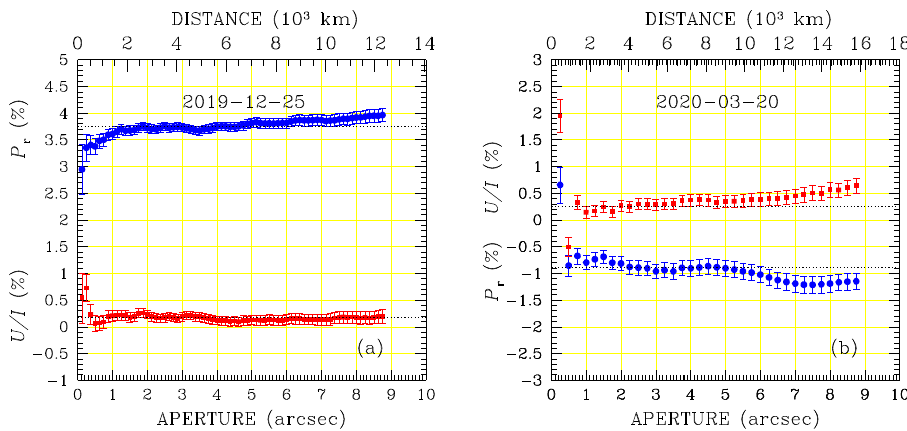
Fig. 5 Aperture polarimetry of 2I/Borisov in the R F fi lter. Blue fi lled circles refer to P r and red fi lled squares refer to U / I . The dotted black solid lines show the values adopted in Table 1. Panel a refers to data obtained on 2019-12-25, when polarisation was directed along the direction perpendicular to the scattering plane. Panel b refers to observations obtained on 2020-03-20, when polarisation was directed along the scattering plane; for these observations, CCD readout was rebinned 2 × 2, which explains the less re fi ned sampling of the growth curve (compared to a ). Reduced Stokes parameters are computed in circles of radius given in the abscissa. The Wollaston strip is 22 ″ wide, therefore aperture radius cannot be larger than 11 ″ . Practically, the aperture limit is determined by the contamination of background stars (see Fig. 3). Error bars are calculated as explained in Methods subsection